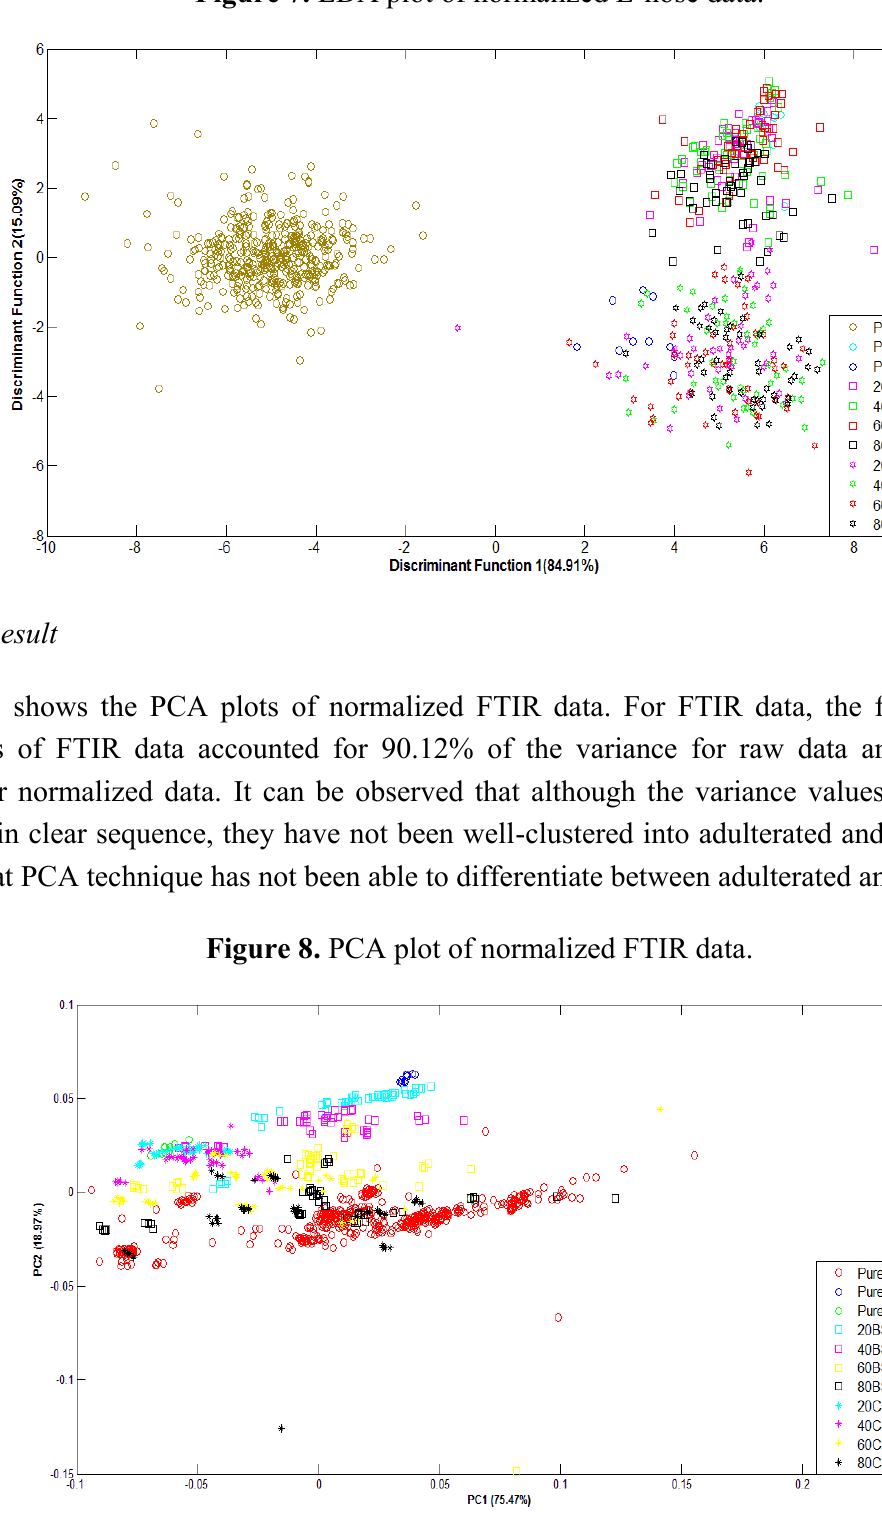
Figure 7. LDA plot of normalized E-nose data.